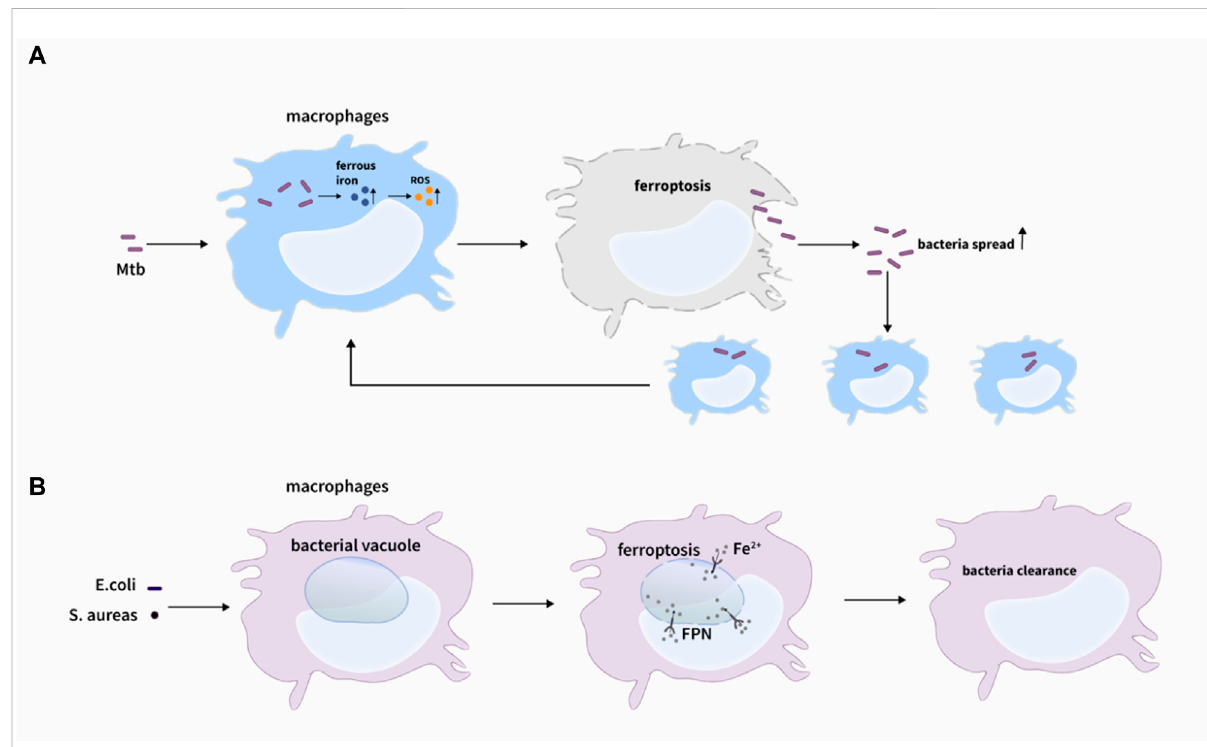
FIGURE 4 Ferroptosisandbacteriainfections. (A) Lipidperoxidationinducesplasmamembranedestabilization,leadingtoferroptosis-mediatedcelldeath with M. tuberculosis infection, and ferroptosis drives macrophages necrosis and allows M. tuberculosis to thrive and spread, which promote the infection (Amaral et al., 2019). (B) Ferrous iron could be delivered to the intracellular bacterial vacuole via inward FPN transportation, eventually inducing ferroptosis-like death of bacteria, which assists killing bacteria of macrophages (Ma et al.,